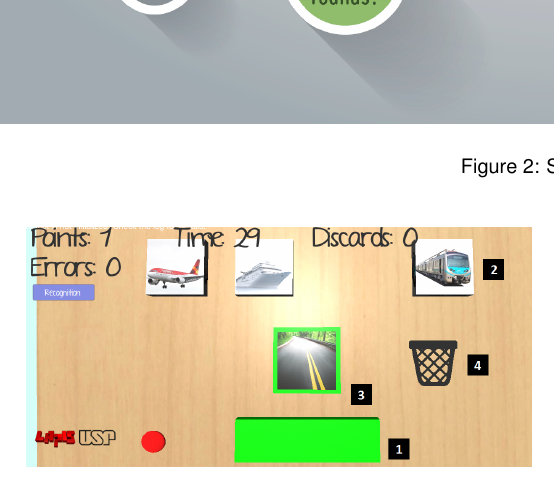
Figure 3: Interface of the AGaR where Area 3 is outlined with green color, demonstrating that the combination of the car with the road was